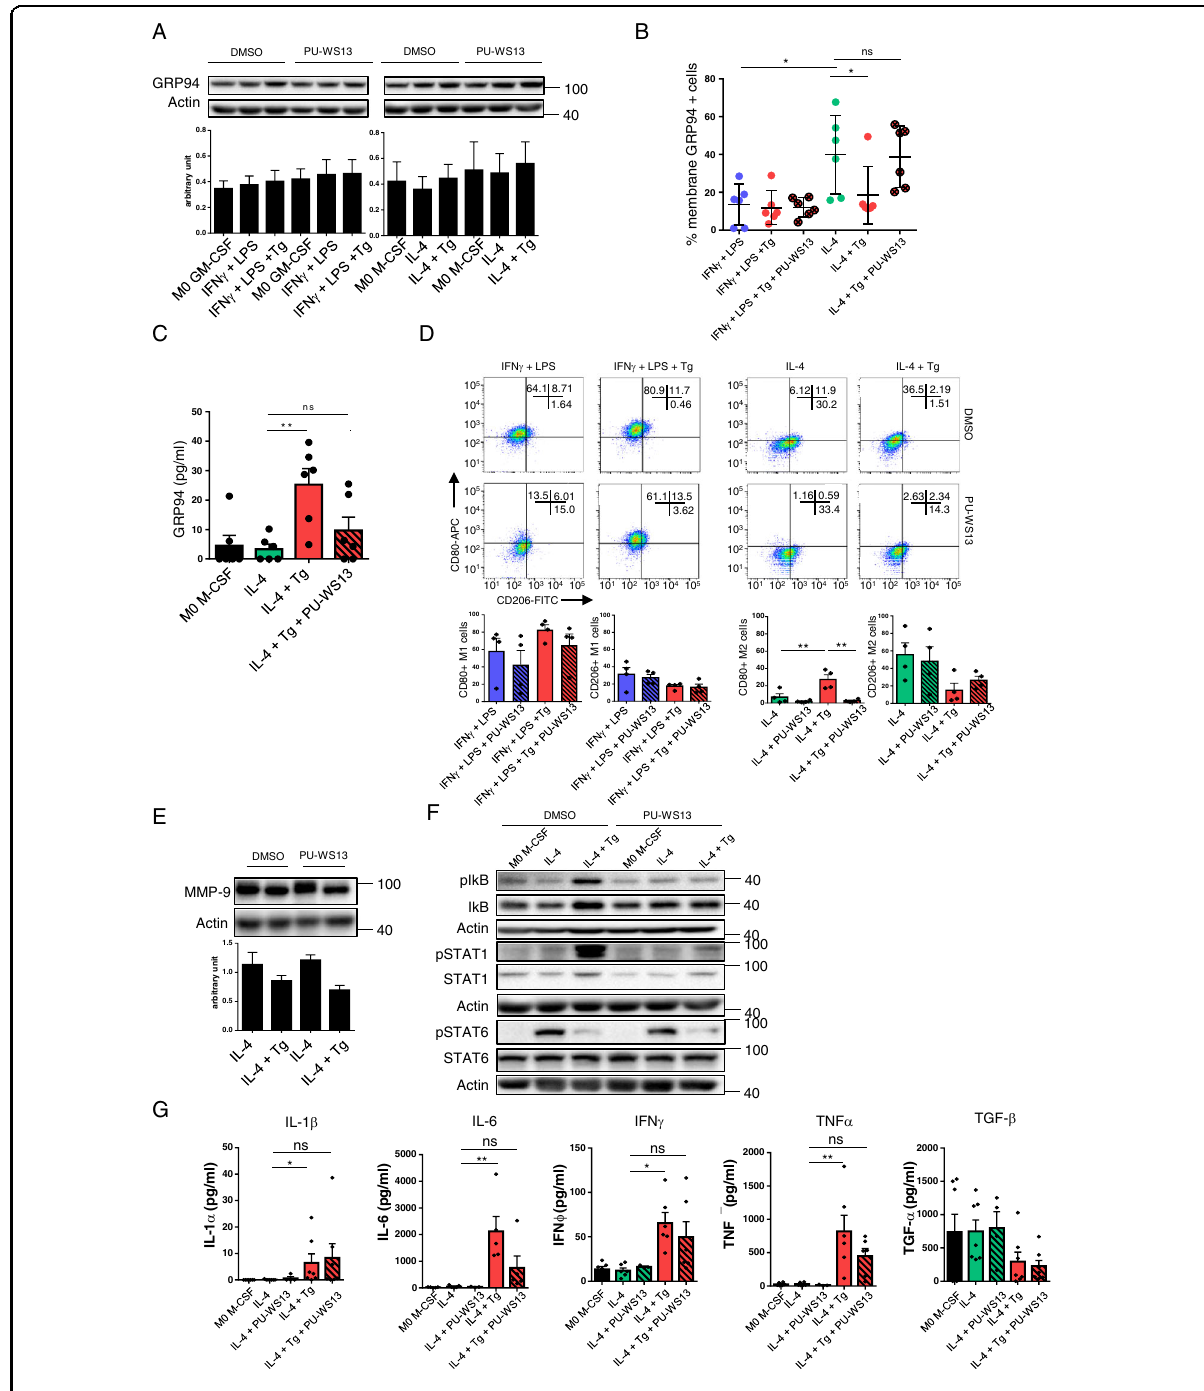
Fig. 3 Inhibition of GRP94 by PU-WS13 impairs the effect of Tg-induced ER stress on M2 macrophages. M1 and M2 macrophages from PBMC healthy volunteers were activated in the presence of GM-CSF and M-CSF, respectively. Tg was added to cell cultures during the 48 h activation period. PU-WS13 or DMSO as vehicle was added in cell culture medium at the concentration of 25 μ M 24 h before and during all the activation period. A Intracellular GRP94 western-blot analysis ( n = 3). B FACS analysis of membrane GRP94 expression ( n = 6). C GRP94 quanti fi cation by ELISA in activated M2 cell culture supernatants ( n = 6). D CD80 and CD206 analysis by fl ow cytometry ( n = 4). E , F Western blot analysis of MMP9 in activated M2 macrophages ( n = 4) ( E ) and of the signalization proteins pSTAT1/STAT1, pSTAT6/STAT6 and pI κ B/ I κ B ( n = 4) ( F ). G Analysis of pro- and anti- in fl ammatory cytokines in M2 cell culture supernatants ( n = 5 – 7). IL-1 β , IL-6, IFN γ and TNF α were quanti fi ed by the Multiplex ™ method and TGF- β was quanti fi ed by ELISA (* p < 0.05; ** p < 0.01; *** p < 0.005; **** p < 0.001).